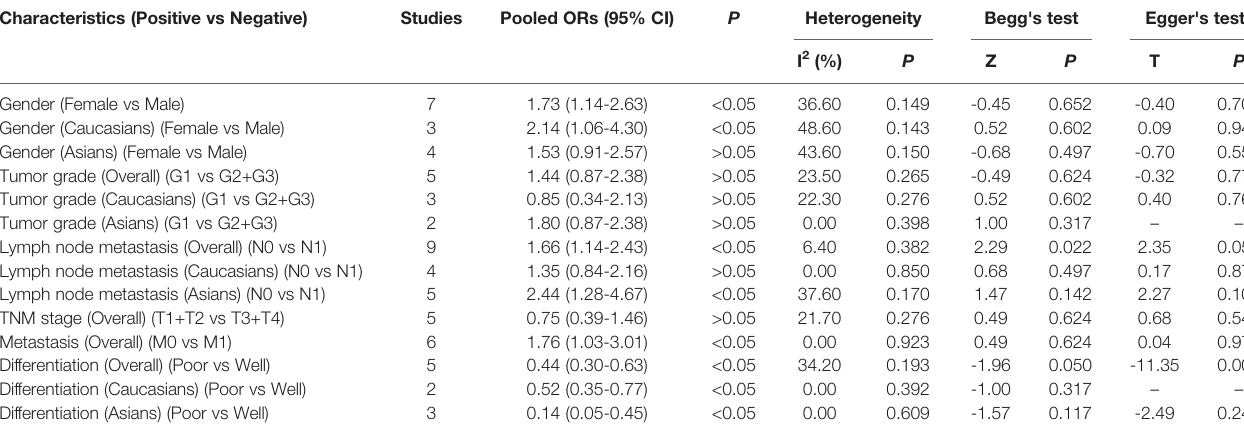
TABLE 5 | Meta-analysis results of pooled ORs for clinical features in PDCA patients. Characteristics (Positive vs Negative) Studies